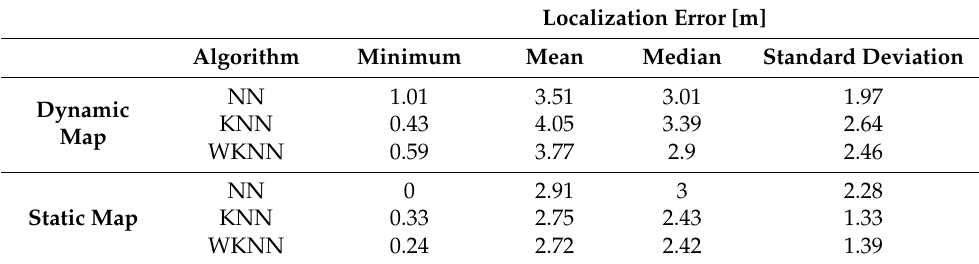
Table 3. Localization error.